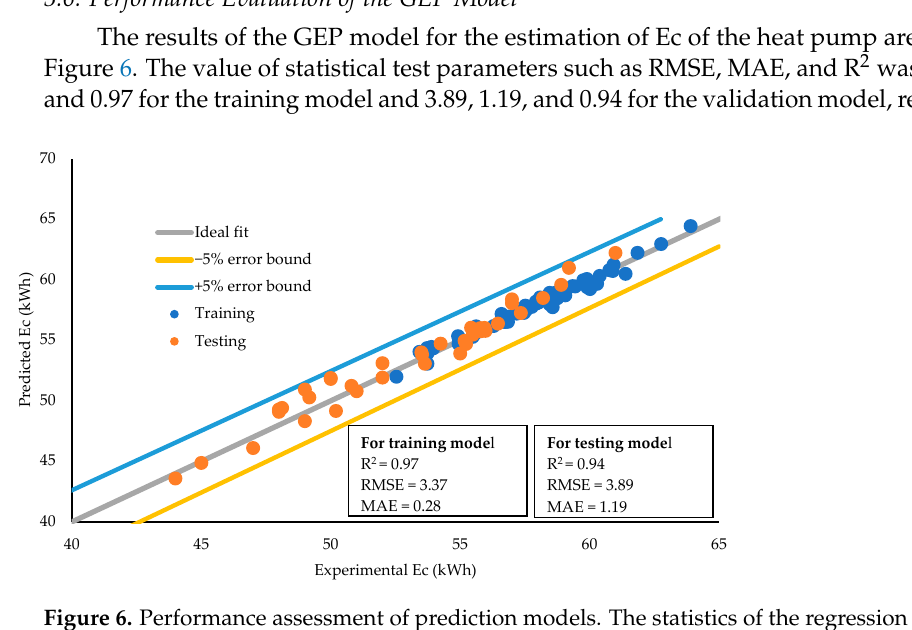
Figure 7. Absolute error plot for GEP prediction model to compare absolute error. The predicted and experimental responses of the GEP model are shown in Figure 8. It can be observed that the predicted and experimental responses overlap with each other representing the strong coherency and correlation between the experimental and pre- dicted response.